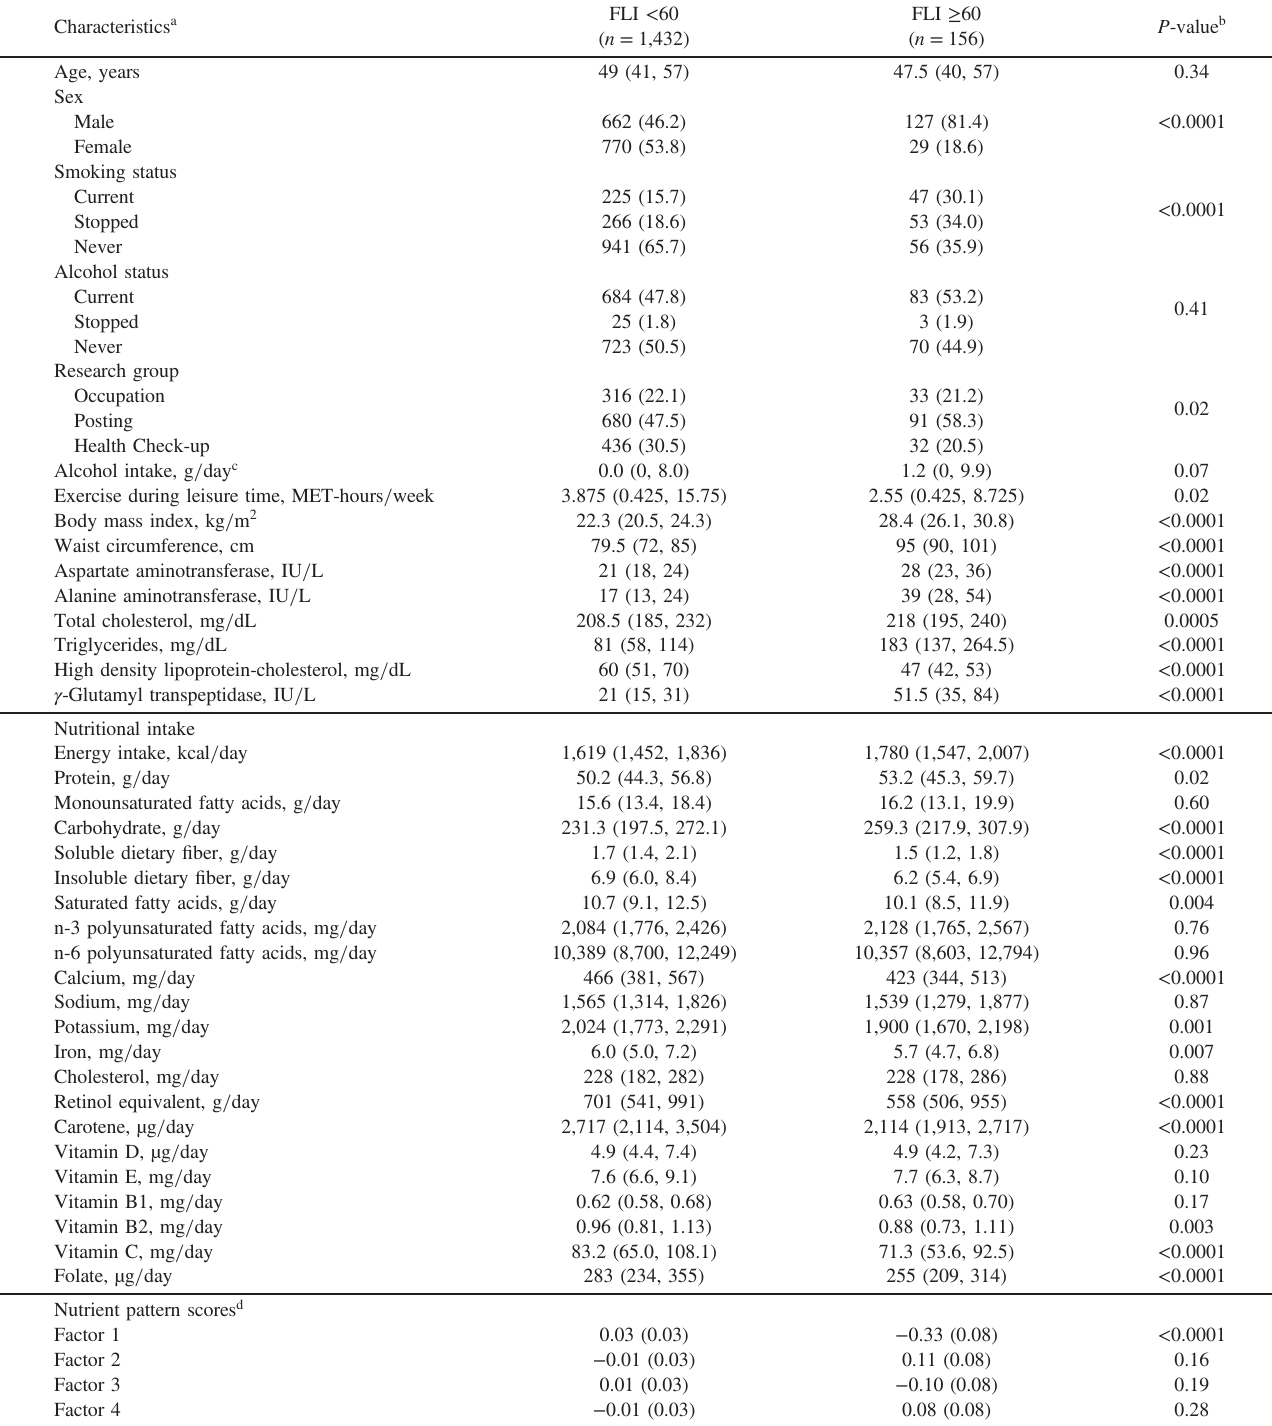
Table 1. Background characteristics of the study subjects according to Fatty Liver Index (FLI) category Characteristics